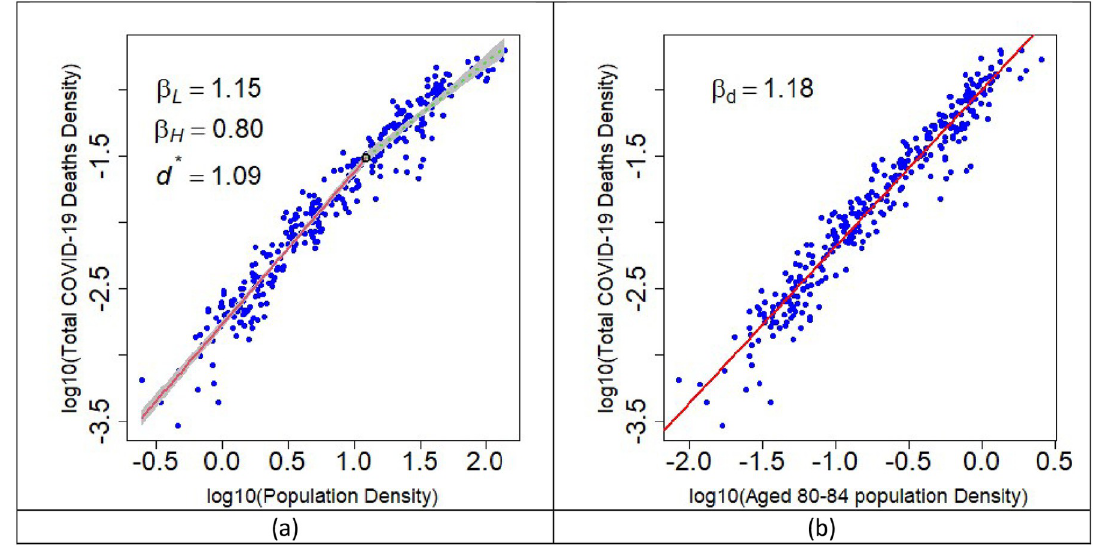
Fig 7. Scaling relationship for COVID-19 death when looking at (a) Total Population and (b) restricted to the 80–84 age group. In (a) a segmented relationship is better fitted where the black circle is the identified critical density. The red line is below and the green line is above the critical density. In (b) the segmented relationship disappears, and a single power-law is the preferred model. The decline in COVID-19 in urbanised regions is no longer viable when age range is